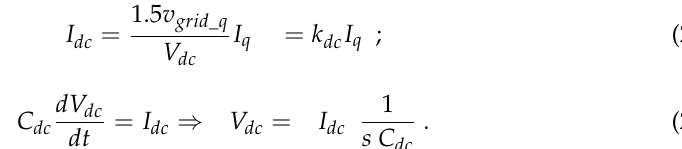
Figure 7. Equivalent circuit of VSI voltage loop.